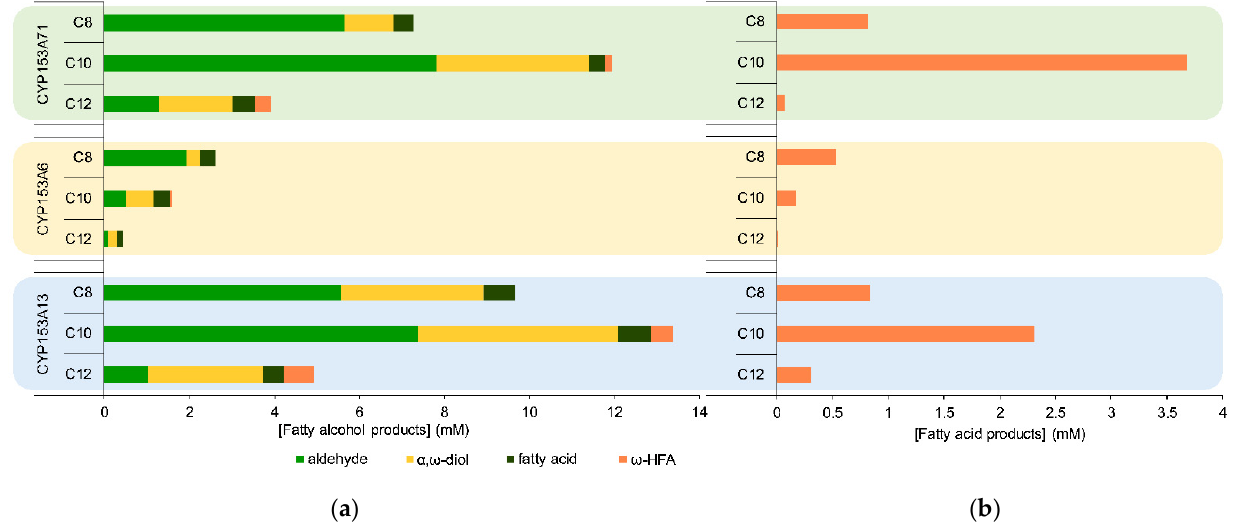
Figure 4. Comparative biotransformations of ( a ) C8–C12 1-alkanols (50 mM) and ( b ) C8–C12 fatty acids (20 mM) by CYP153A71, CYP153A6, and CYP153A13 Results are averages from two independent experiments, each with three biological replicates.